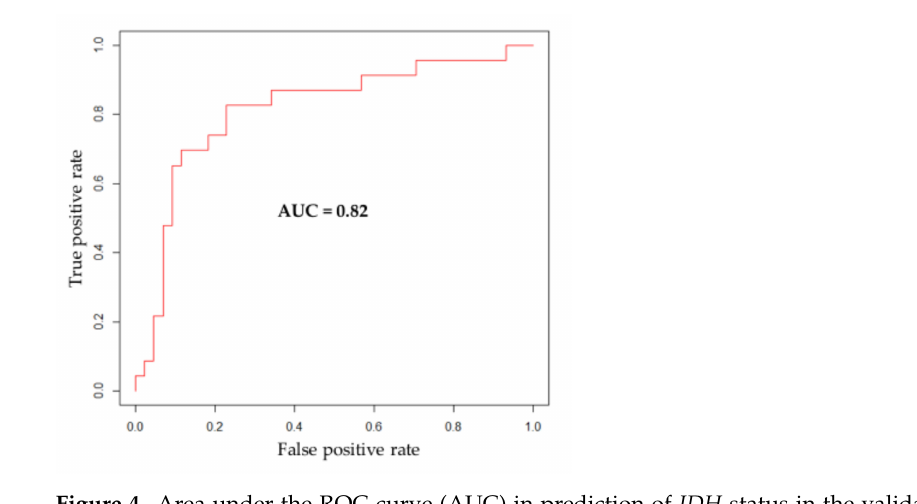
Figure 4. Area under the ROC curve (AUC) in prediction of IDH status in the validation cohort. IDH : isocitrate dehydrogenase .